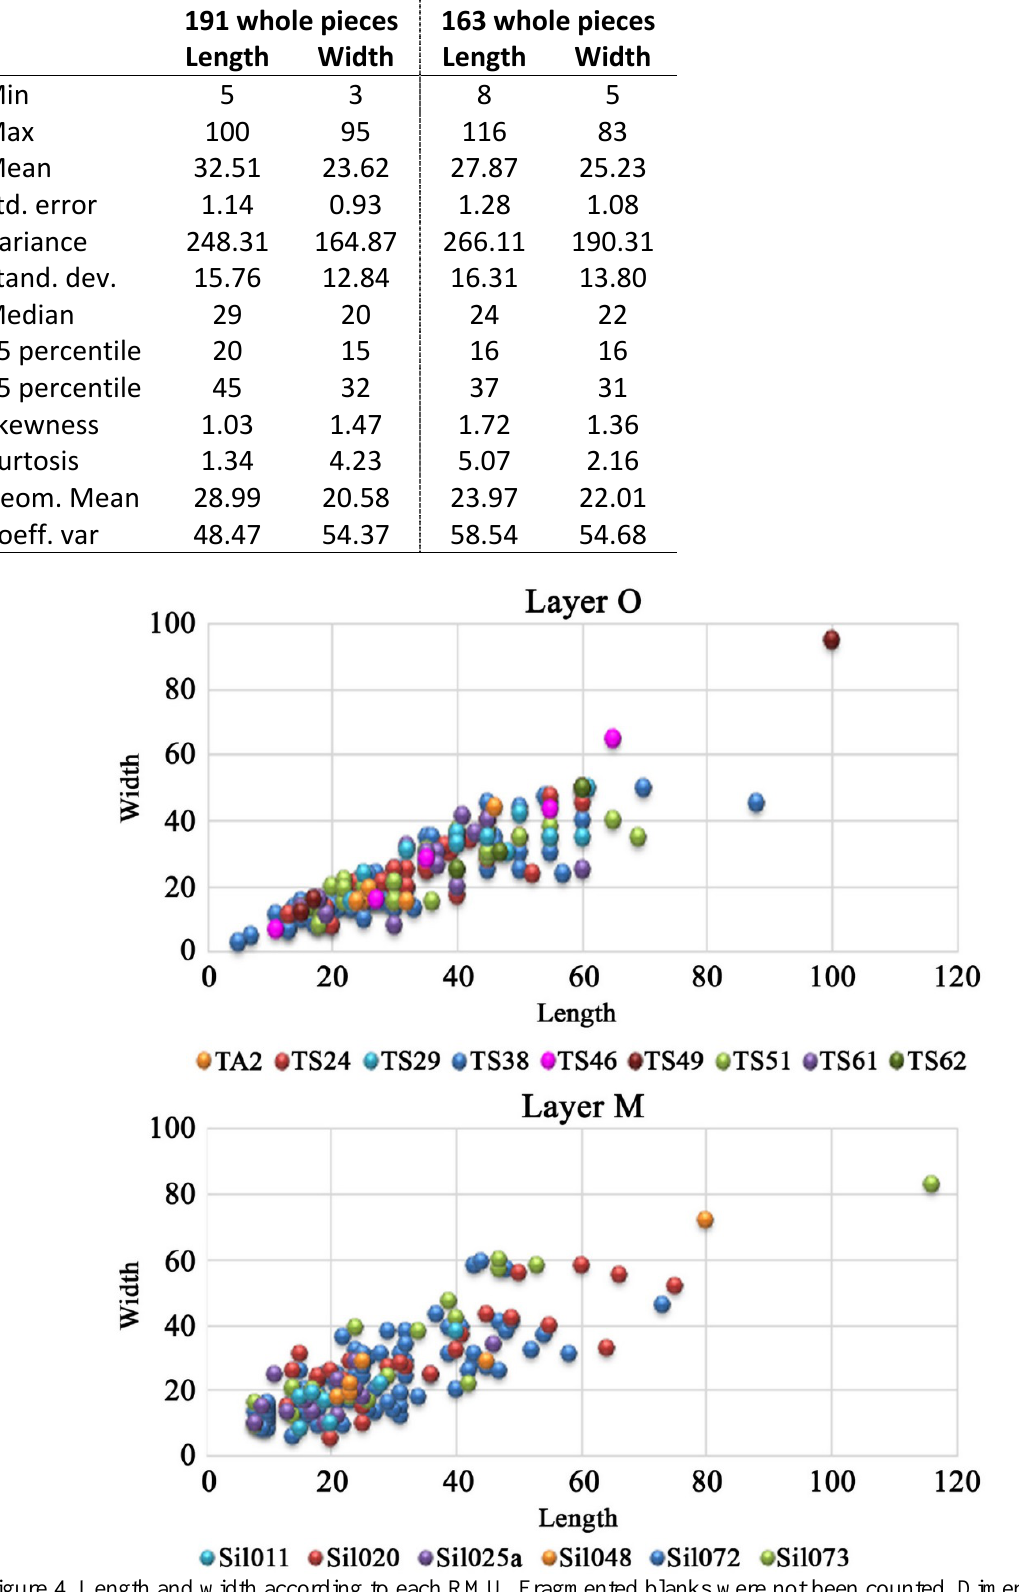
Figure 4. Length and width according to each RMU. Fragmented blanks were not been counted. Dimensions are in